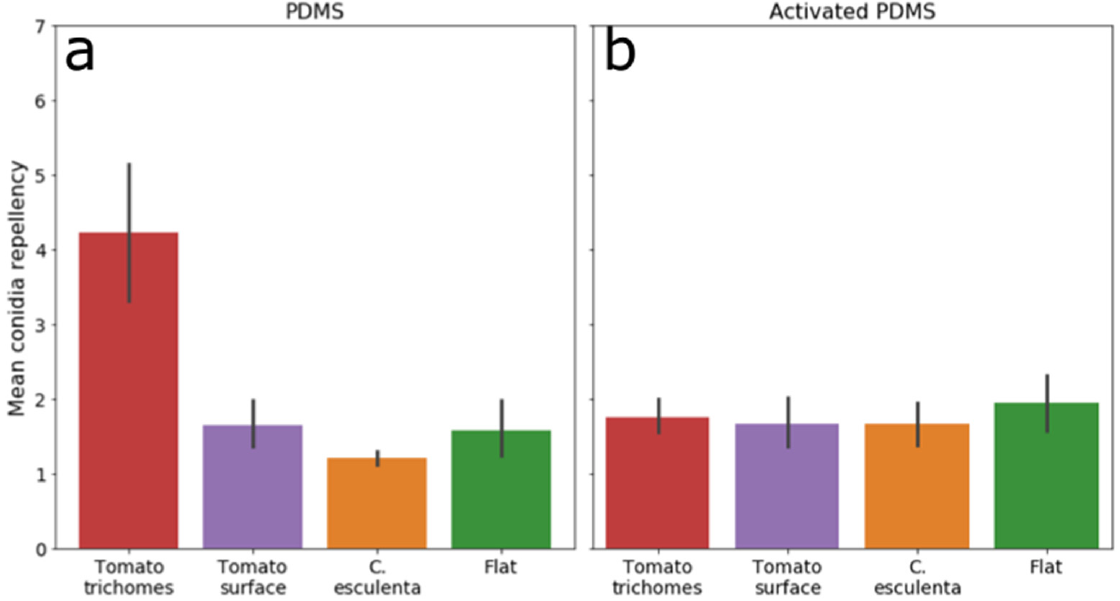
Figure 7. Washing efficiency of all synthetic surfaces separating trichomes from the rest of the sur- face. Summarization of washing efficiencies of all synthetic surfaces examined in this study. ( a ) PDMS surfaces, ( b ) Activated PDMS surfaces. Trichomes were counted separately from the rest of the tomato surface (red and purple bars, respectively). Only hydrophobic trichomes had washing efficiency significantly higher than all other surfaces